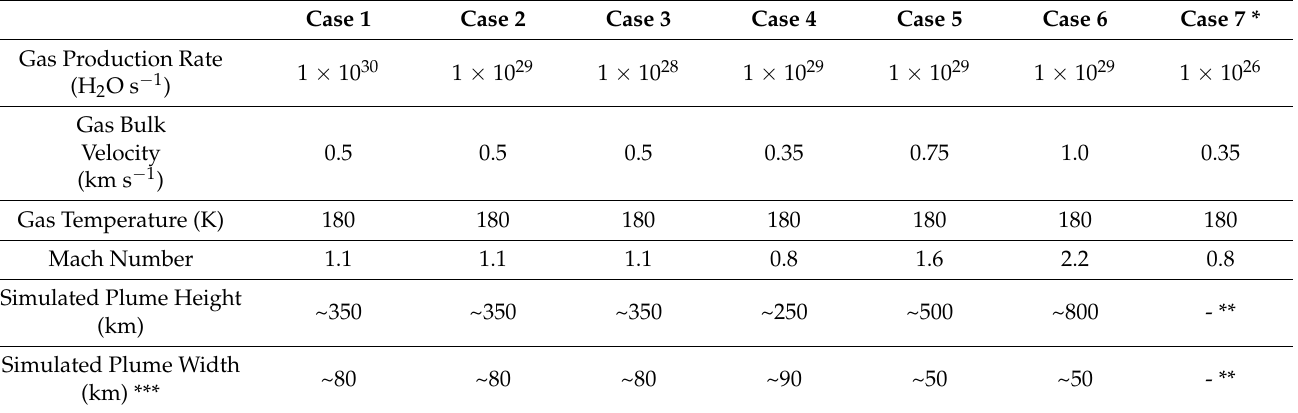
Table 1. The initial conditions in the case studies with a circular source area of a radius of 20 km. * A special case 7 simulated a possible stealth plume with a circular source area with a diameter of 10